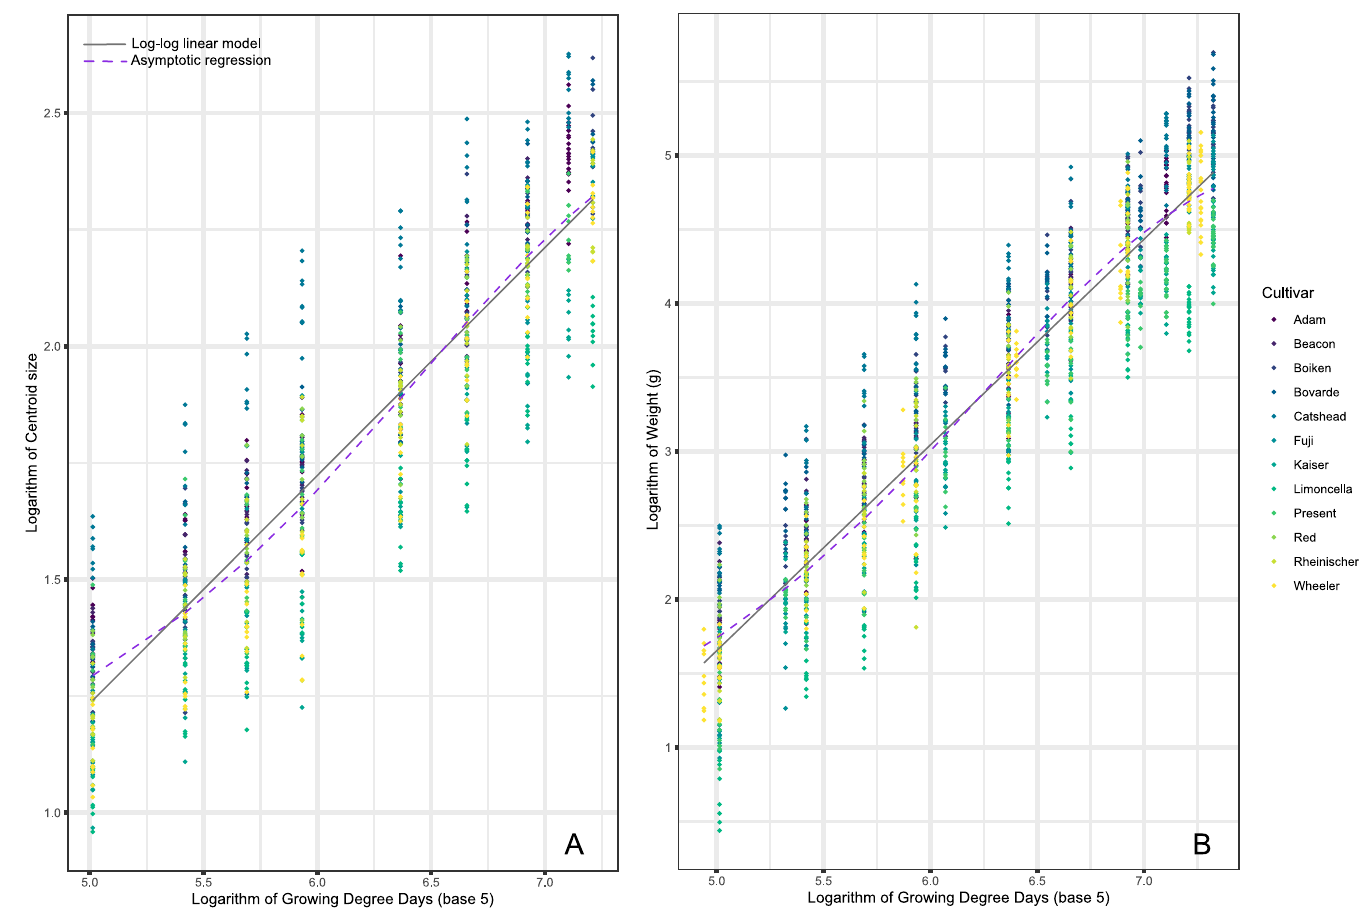
Fig 2. Model fit for log-log linear regression (solid grey) and asymptotic regression (dashed purple) between growing degree days and measured morphometrics (A: Centroid Size, B: Weight). Twelve apple cultivars were sampled throughout the 2013 growing season, with six of them repeated in the 2014 growing season. Both growing degree days and respective morphometrics are logarithmically transformed for illustration purposes. Growing degree days are base 5.